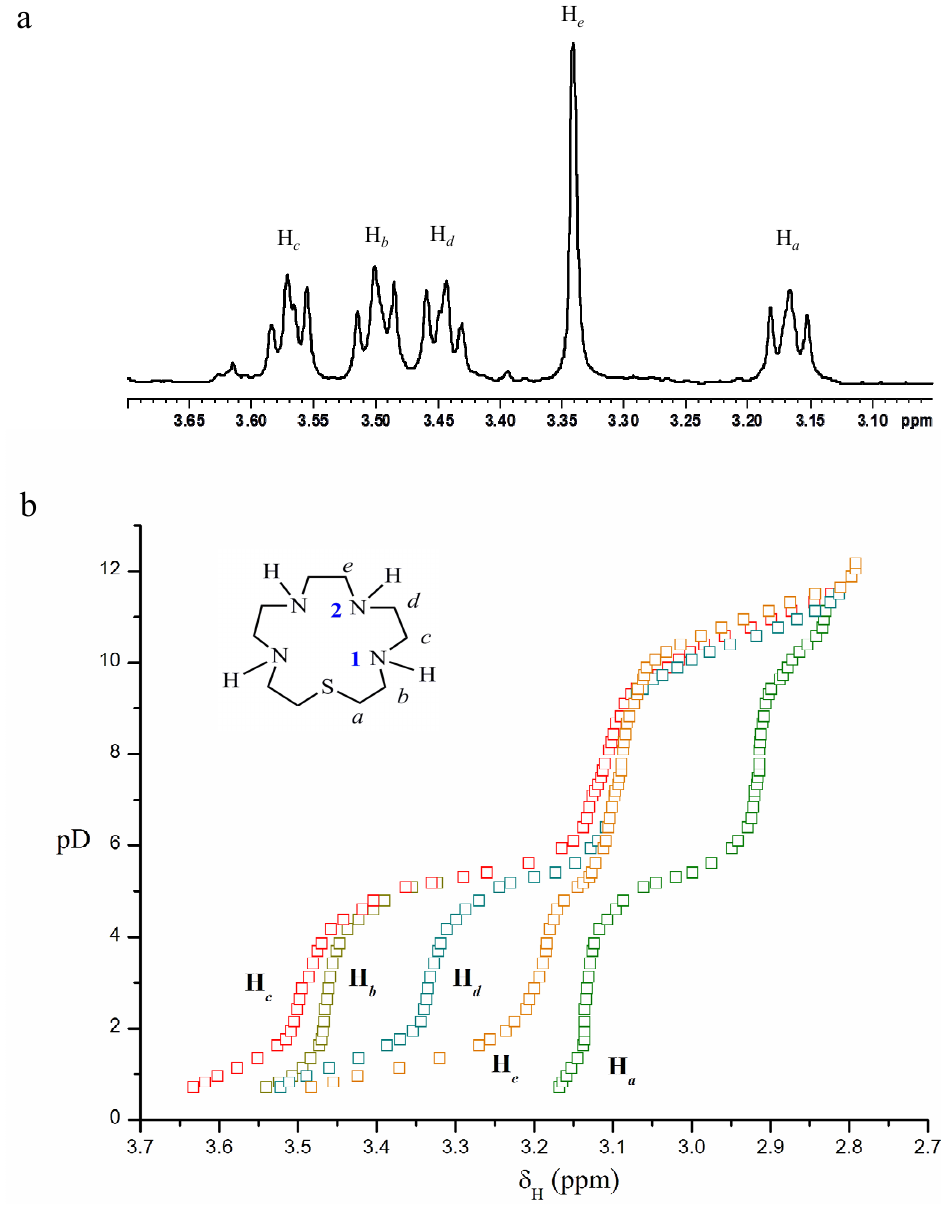
S in D O, pD 1.72; ( b ) 1 H - NMR titration 4 2 (ppm) in function of H